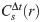
Spatial correlation between loci displacements.(A) Spatial correlation of loci displacements CsΔt(r) (Eq 4) with varying lag time (Δt). (B) Correlation length lc(=∫0∞[CsΔt(r)/CsΔt(a)]dr) as a function of Δt. Visualized on 3D chromosome structure are the displacement correlations of chromatin loci probed at short and large time gap (Δt = τBD and 103
τBD) projected onto the xy-plane. The color-code on the structures depicts the azimuthal angle of loci displacement. (C) The displacement vector of loci in the equator plane are color-coded by direction. In each panel, the displacement vectors Δr→(t=0;Δt) are calculated for Δt = 1, 100, 1000 τBD. Direction-dependent color scheme is depicted on the right.